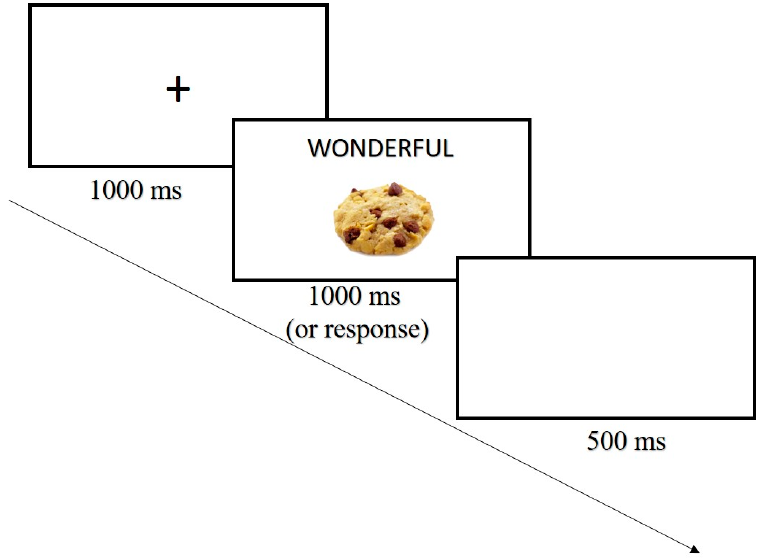
Figure 3. An example of a positive food trial of the food–valence compatibility task (FVCT) used in Experiment 2. Participants are asked to classify pleasant words to a “positive” category and unpleasant words to a “negative” category.